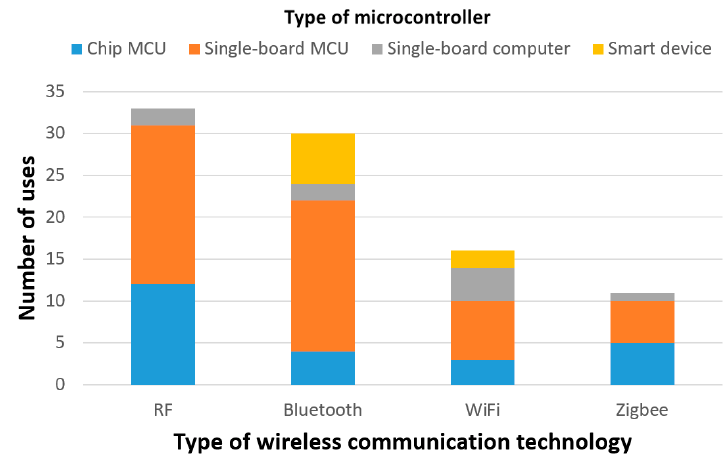
Figure 11. Number of uses by wireless communication technology and microcontroller types in smart helmet studies.